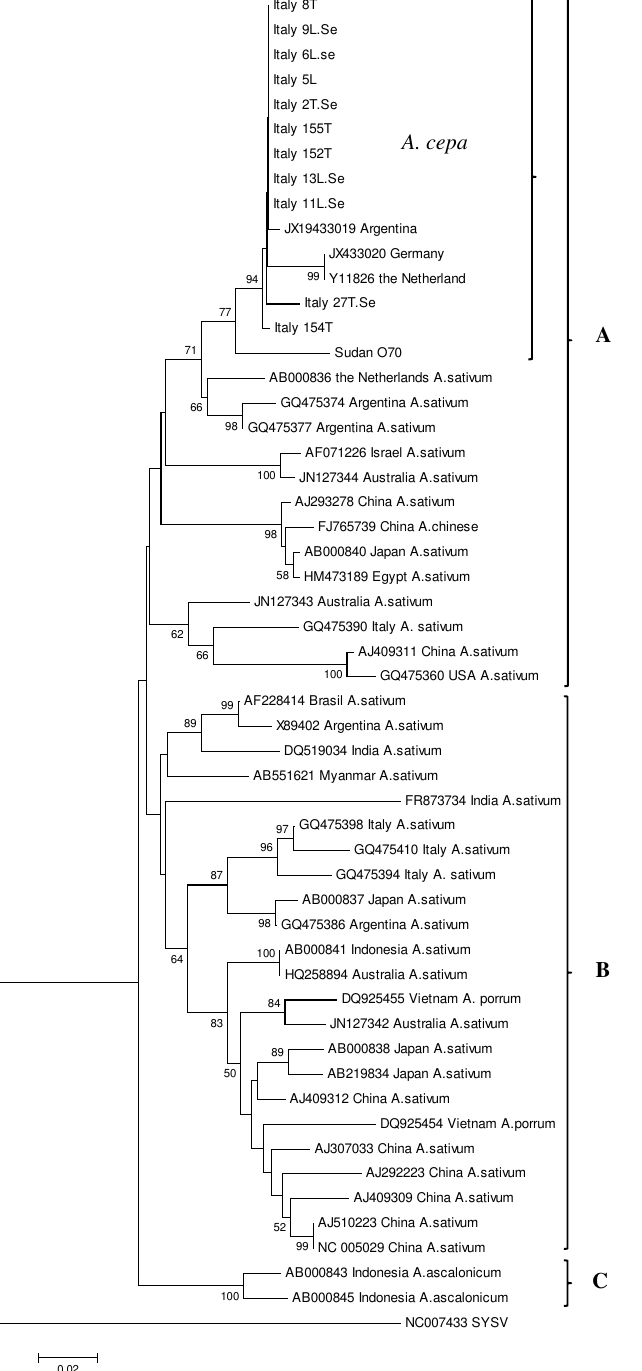
Figure 4. Neighbour-joining tree based on multiple alignment of complete CP protein sequences of OYDV between Italian and Sudanese isolates from this study, three onion isolates and 35 garlic isolates available from the database. The sequence of SYSV (NC007433) was used as an out-group. Bootstrap percentages of clades, reported along the branches of the tree with value >50%, derived from bootstrap-resampled data sets (1000